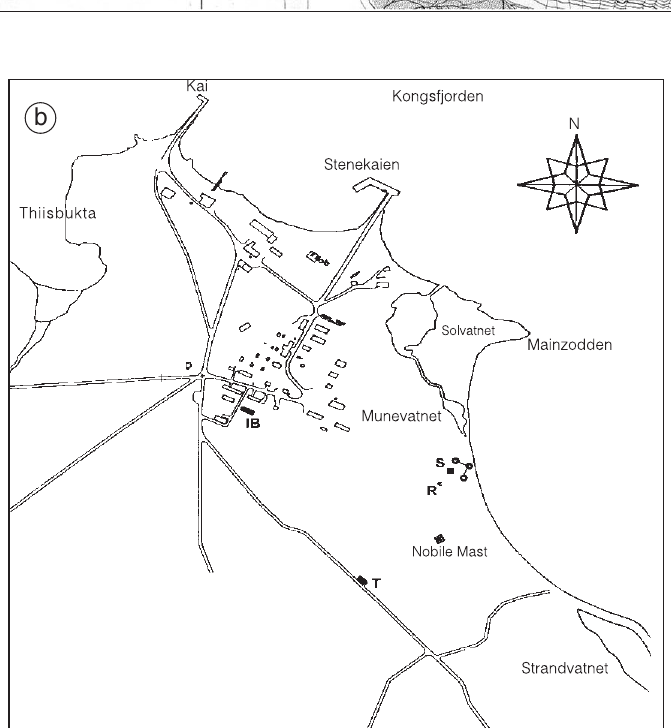
Fig. 1a,b. a) Map of the Kongsfjorden Spitsbergen Island; b) map of Ny-Ålesund and location of the experiment sites: 3-axes Doppler Sodar (S), Radiation and fast response sensors mast (R), Italian Base (IB), Tethersounding station 187